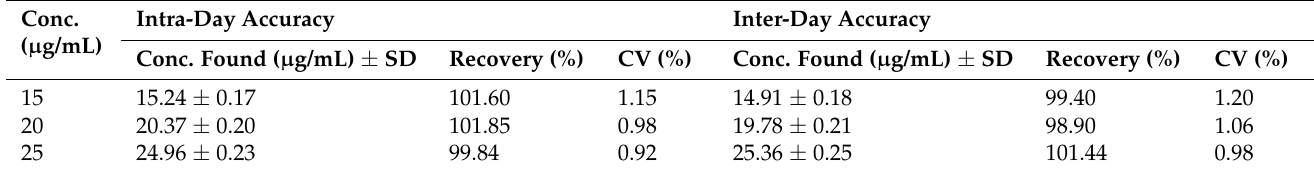
Table 4. Intra-day and inter-day accuracy data of CCM for the greener HPLC methodology (mean ± SD; n = 3).